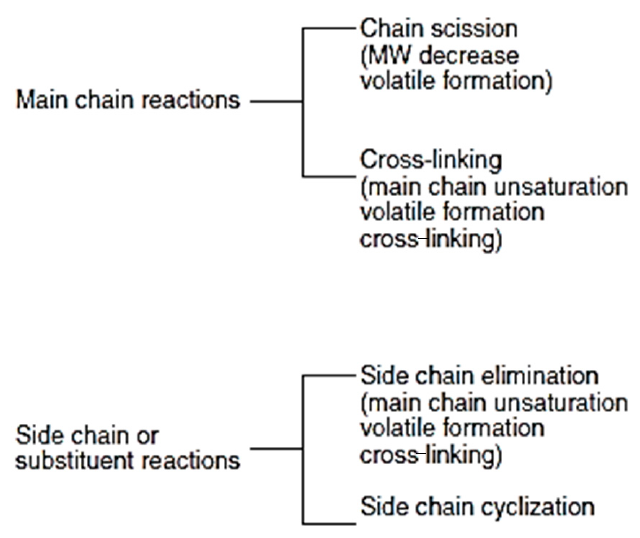
Figure 5. Thermal decomposition mechanisms in polymers [20]. Table 3. Yield in thermal and catalytic pyrolysis of HDPE and LDPE [22]. Pyrolysis Product Yield (wt. %)